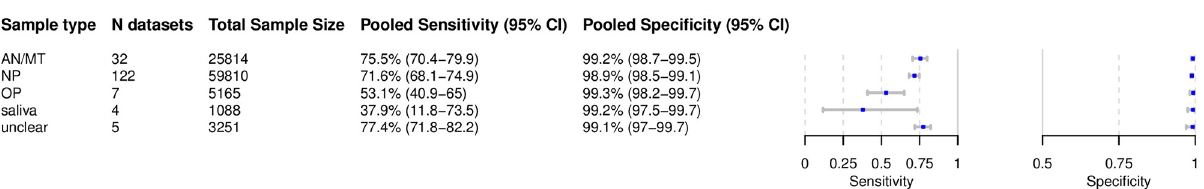
Fig 8. Pooled sensitivity and specificity by sample type. AN, anterior nasal; MT, mid-turbinate; NP, nasopharyngeal; OP, oropharyngeal.